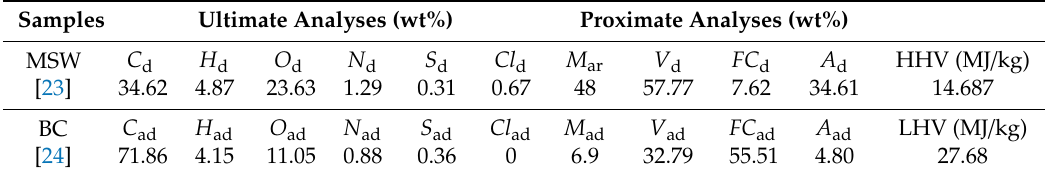
Table 1. The proximate and the ultimate analyses of raw municipal solid waste (MSW) and bituminous coal.